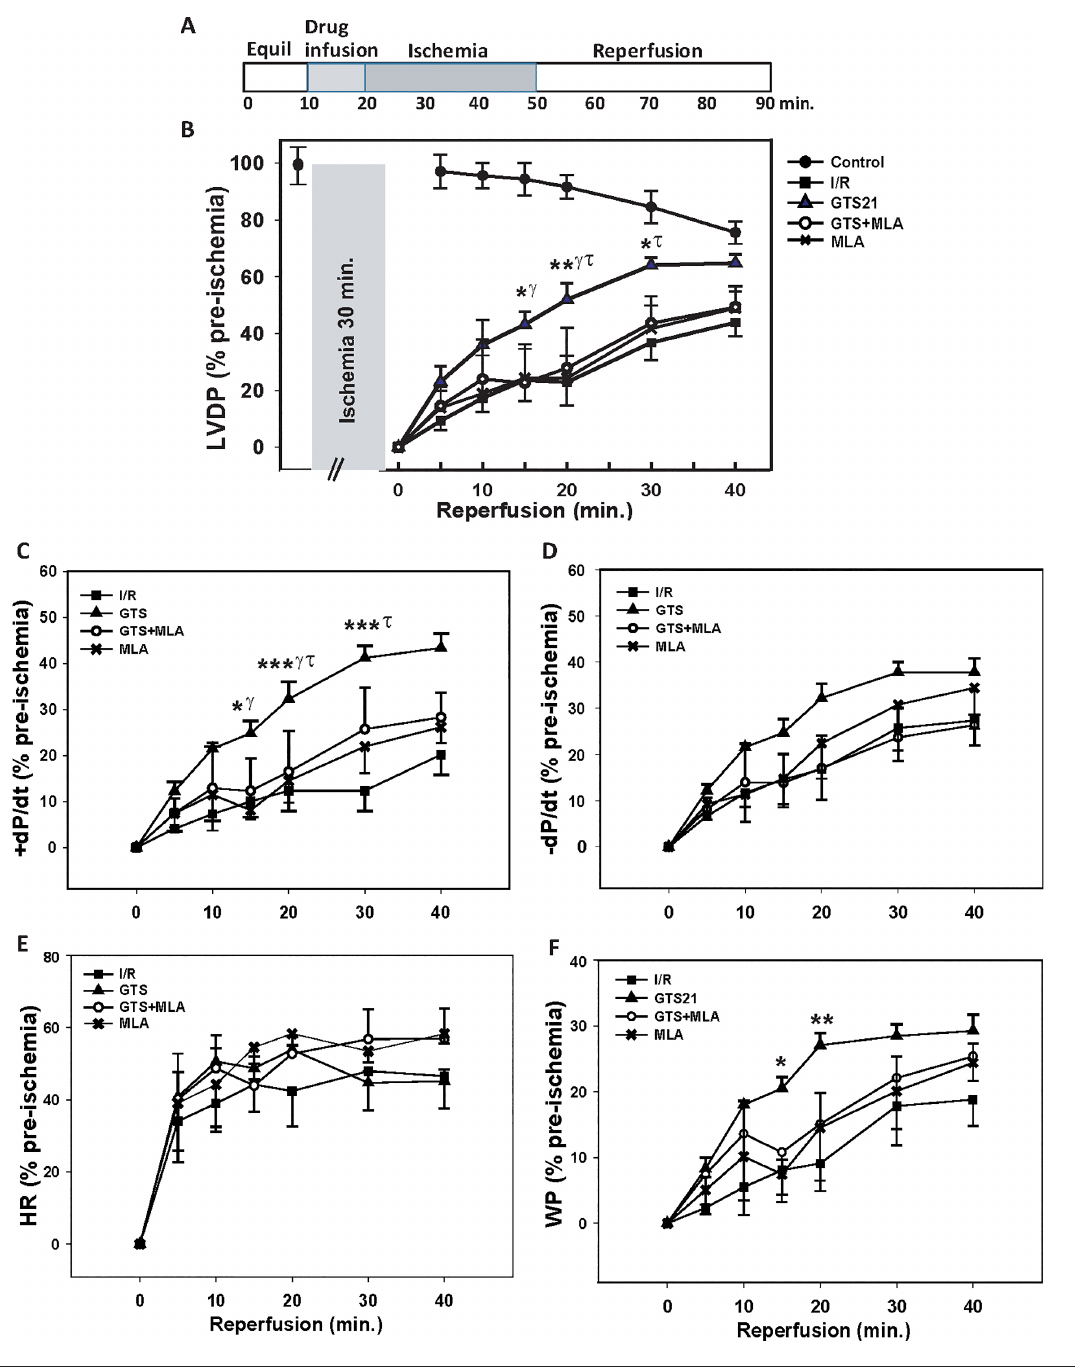
Figure 1. α 7nAChR activation with GTS21 treatment improved contractile function of I/R perfused rat hearts. (A) Experimental protocol of the rat heart perfusion studies. Equil, equilibration period. (B–F) LV pressures were recorded during the 40 min reperfusion period and five outcome variables (LVDP, + dP/dt, -dP/dt, heart rate [HR], work product [WP]) were measured at 0, 5, 10, 15, 20, 30 and 40 min and are expressed as percent of the value measured at the end of the equilibration period (% pre-ischemia). Data points represent treatment group mean ± SE. Perfusion control (•, n = 5); I/R + vehicle ( ▪ , n = 4); I/R + GTS21 ( ▴ , n = 6); I/R GTS21 + MLA ( ○ , n = 3). I/R + MLA ( x , n = 3). RMANOVA performed on the five outcome variables measured at six time points (0–30 min) showed significant group × time interactions in (B), (C) and (F), and pairwise comparisons between the four treatment groups showed significance at individual time points as indicated: * p < 0.01 versus I/R, ** p < 0.001 versus I/R, *** p ≤ 0.0001 versus I/R, τ p < 0.01 versus GTS + MLA, γ p < 0.01 versus